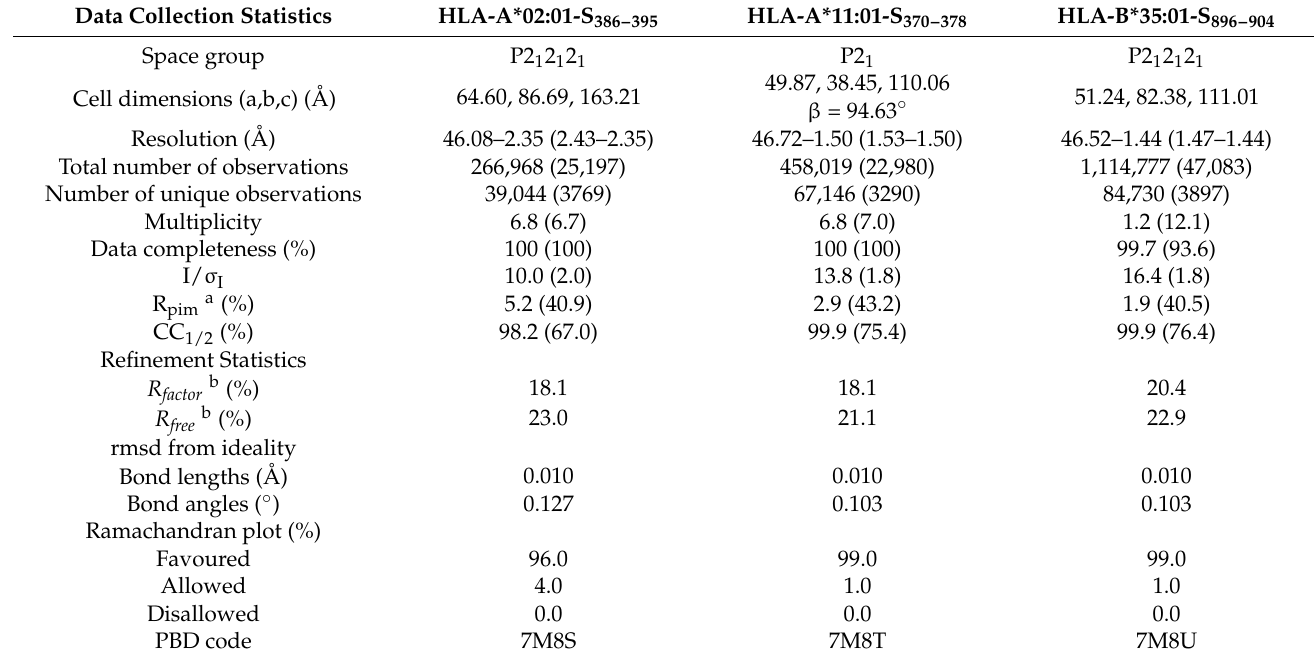
Table 3. Data collection and refinement